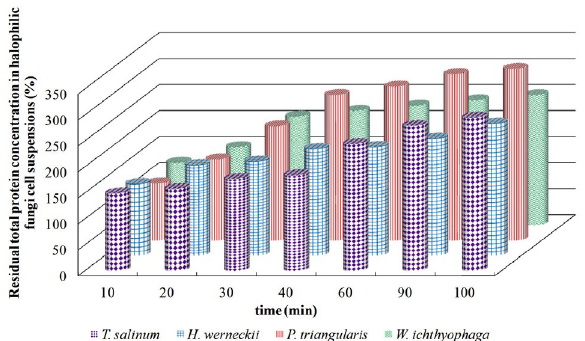
Figure 4: Absorbic ratio (A 260/280) after homogenization of halo- philic fungi cell suspensions at 35 °C and a homogenization speed of 25,000 rpm. Experiments were repeated three times. Standard devi- ation for all measurements was less than ±